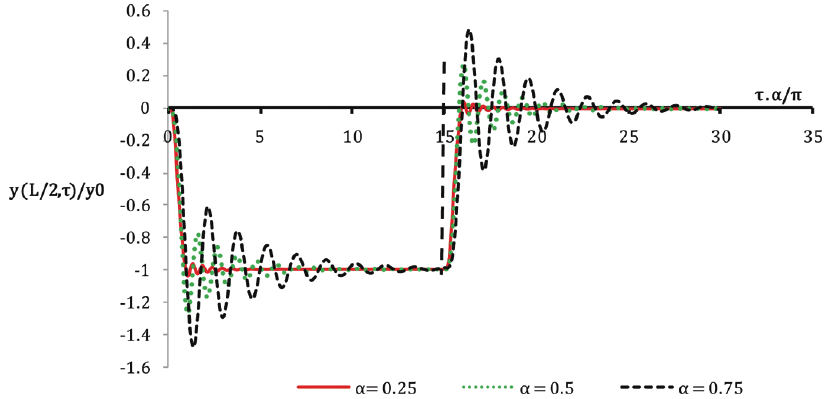
Fig. 12. DLF in terms of τ · α/π for K = 1, E 1 = 0.75 and α < 1.